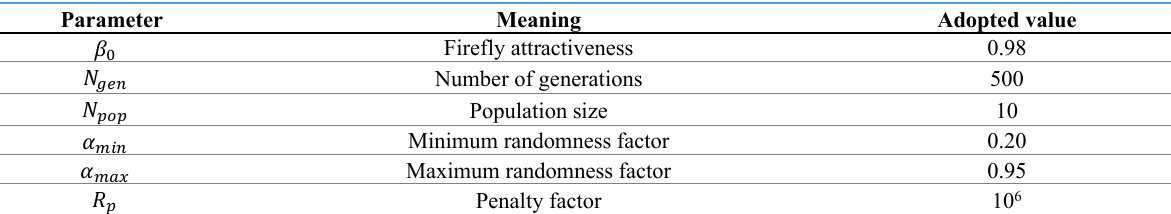
Table 7. FA input